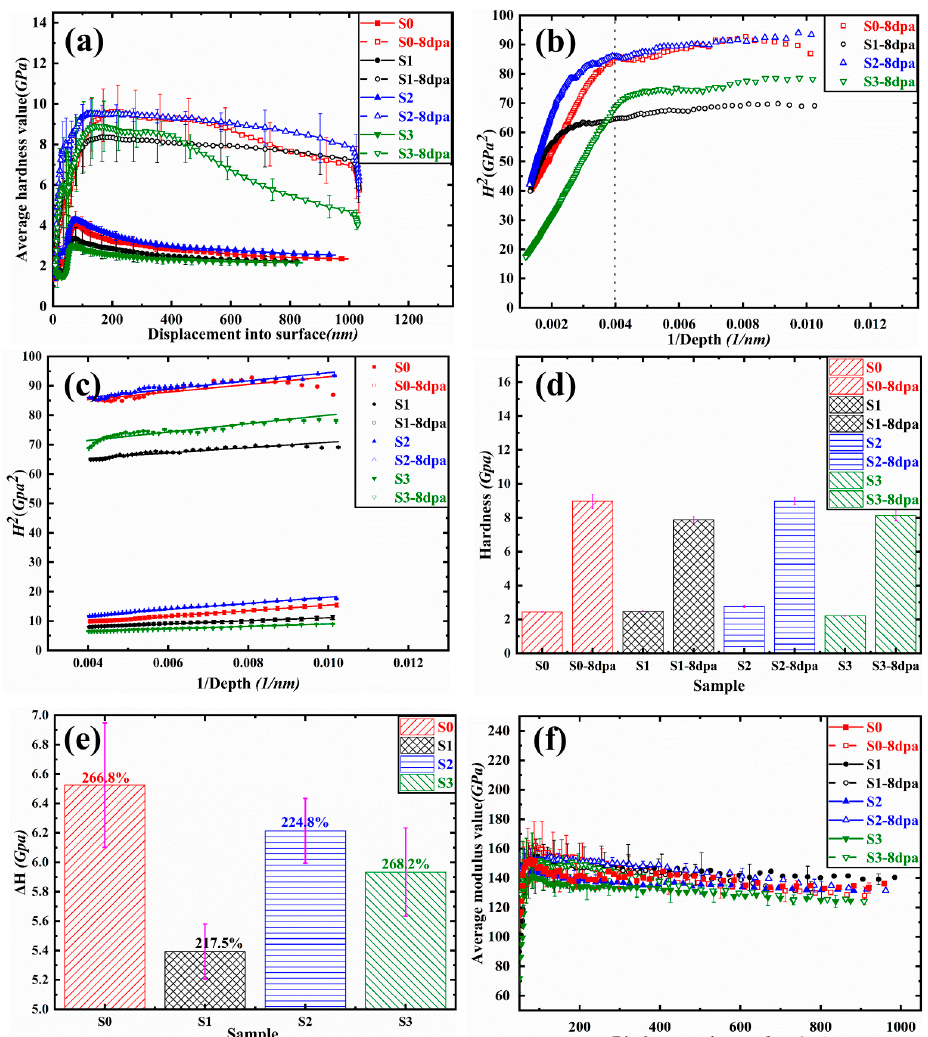
Figure 4. The pictures of ( a ) mean nano-indentation hardness curve, ( b ) fitting curve of hardness in the range of 100–1000 nm, ( c ) fitting curve of hardness in the range of 100–250 nm, ( d ) comparison of hardness increment before and after irradiation, ( e ) Δ H and hardening rate, and ( f ) average curve of Young ’ s modulus.